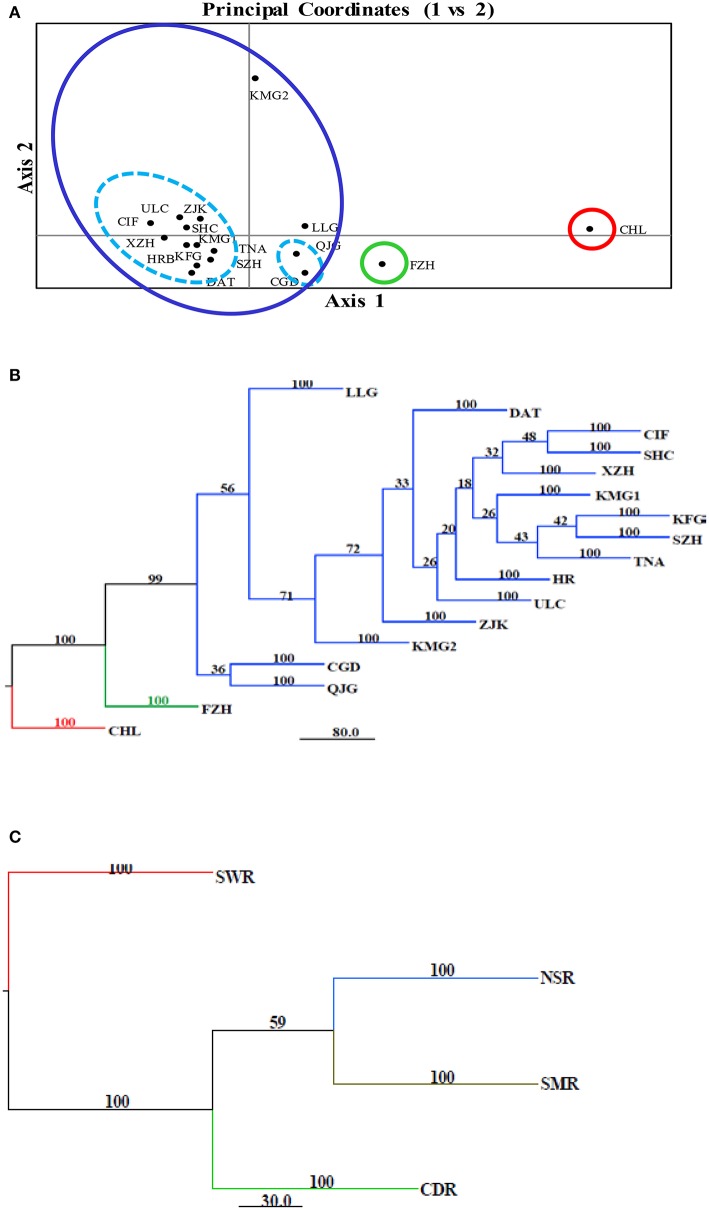
Cluster analyses of 17 Alternaria alternata subpopulations from China. (A) Principal Coordinates Analysis of the pathogen populations using Nei's genetic distance estimated with GenAlEx. The first and second coordinates accounted for 77.25 and 13.27% of the total variance, respectively; (B) Neighbor joining tree of the 17 Alternaria alternata subpopulations reconstructed with the program implemented in the Phylip package; (C) Neighbor joining tree of four regional subpopulations reconstructed with the program implemented in the Phylip package. Bootstrap support was generated by 1,000 resampling of original data using Microsatellite Analyzer.